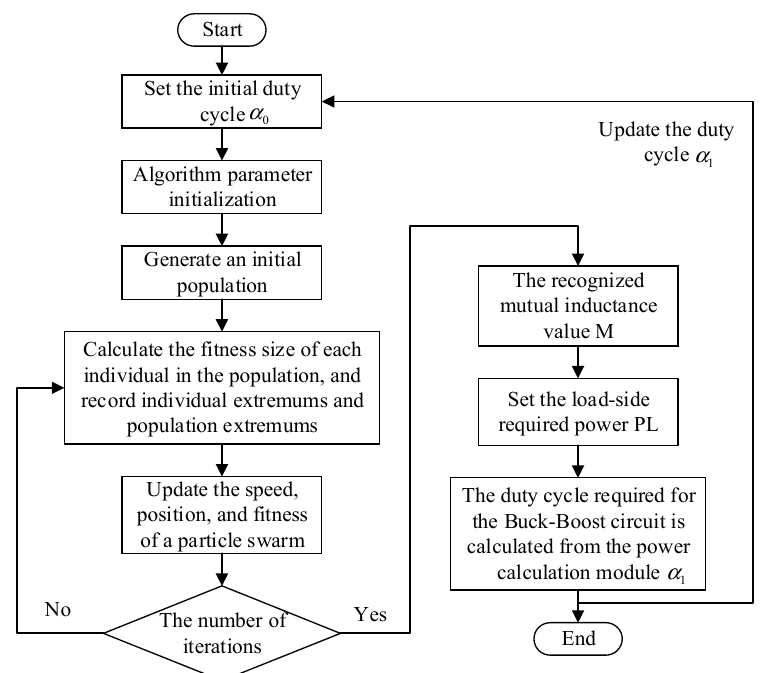
Figure 11. The flow chart of the power stabilization strategy based on the improved PSO mutual sense identification algorithm.